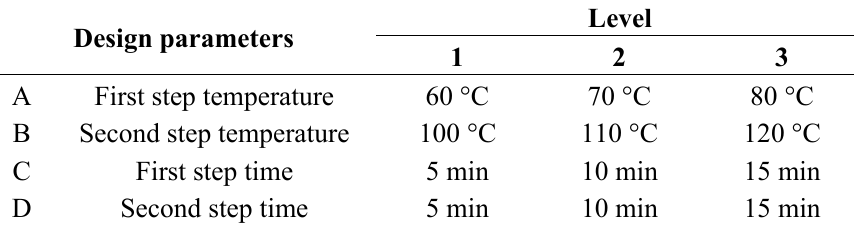
Table 4. Design parameters of the DOE of the three-step cure process.